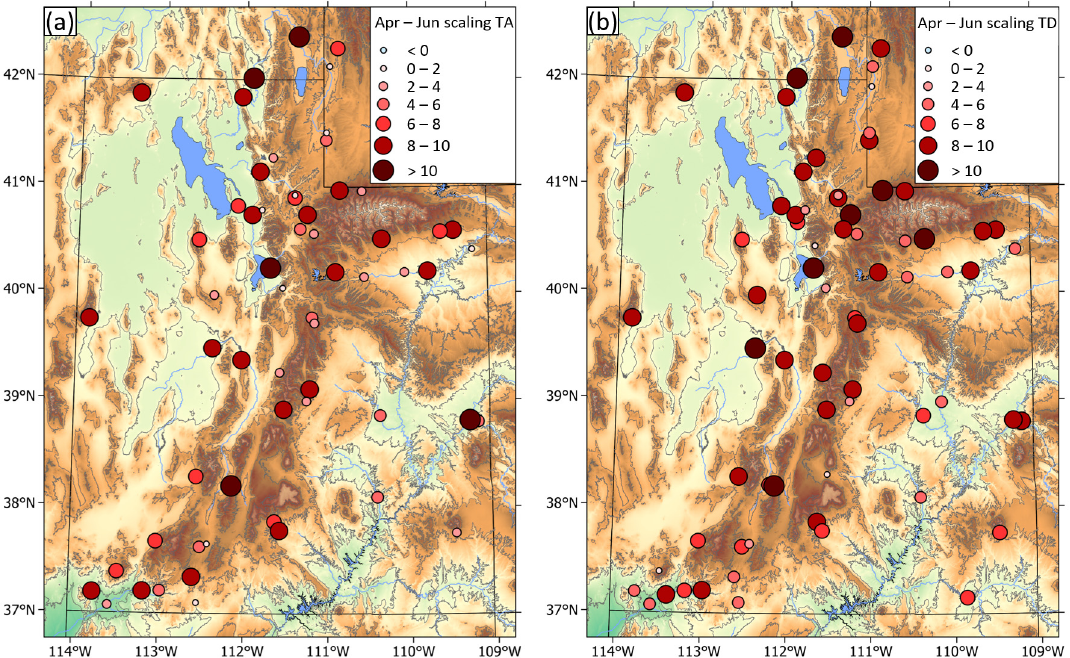
Figure 3. April to June scaling (%) of at least 95th percentile of discharge with ( a ) daily mean air temperature and ( b ) daily mean dewpoint temperature.